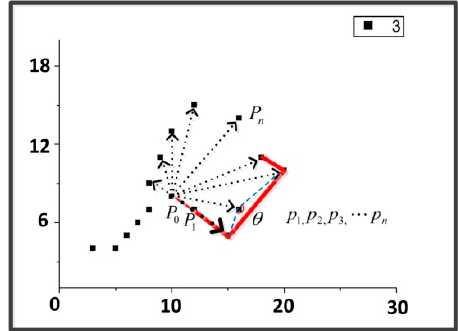
7 of 17 Figure 7. The rectangle trajectory and corresponding calculation. In Equation (8), (𝑥 (cid:3036) , 𝑦 (cid:3036) ) represents any coordinate in the (𝑡 (cid:2869) , ⋯ , 𝑡 (cid:2870) ) period, (𝑥 (cid:2869) , 𝑦 (cid:2869) ) represents the coordinates of